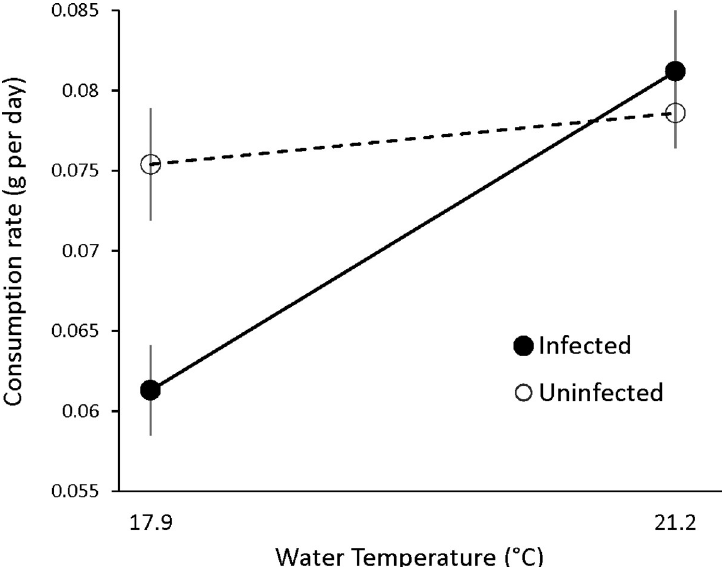
Fig 2. Consumption rate of the green alga Ulva lactuca by large uninfected Littorina littorea snails (open circles, dashed line) and trematode-infected snails (darkened circles, solid line) at water temperatures of 17.9˚C and 21.2˚C. Values are means ± SE. Figure reproduced with permission from [48], Inter-Research 2009. SE, standard error.